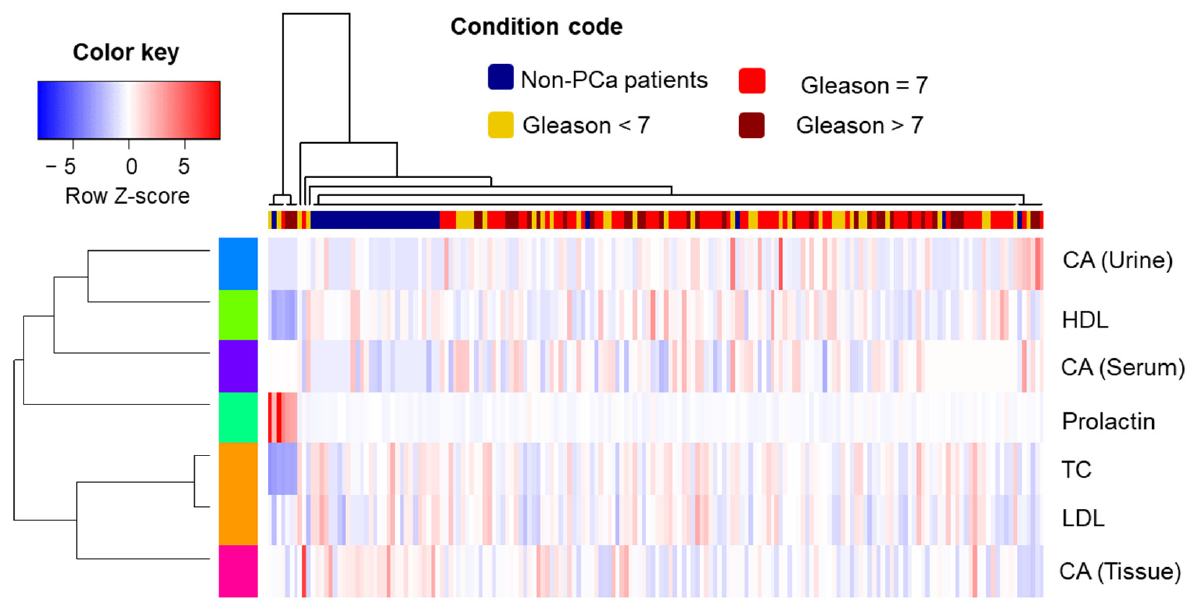
Figure 5. HCA associated with a heatmap; The condition code refers to different PCa stages according to GS. CA = citric acid, LDL = low density lipoprotein, TC = total cholesterol and HDL = high density